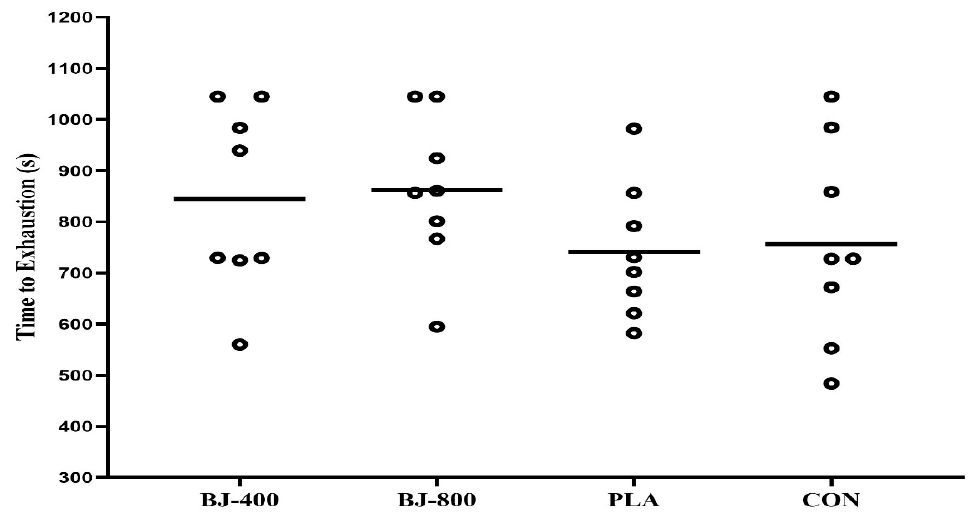
Figure 2. Time to exhaustion during the Progressive Specific Taekwondo Test in four treatments. BJ, beetroot juice; PLA, placebo; CON, control.